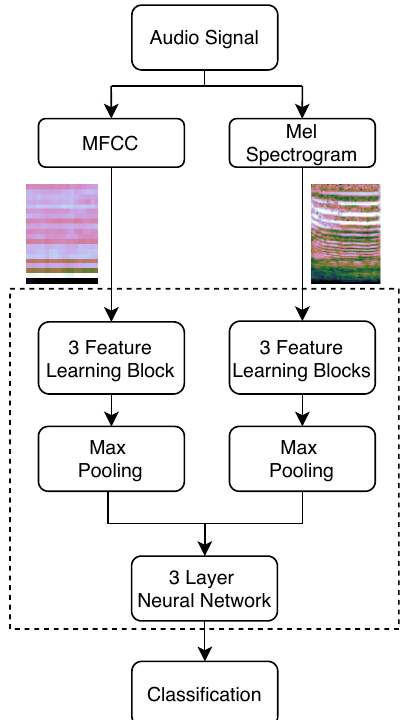
Figure 6. Block Diagram of the designed Multi-Headed 2D Convolutional Neural Network (CNN).